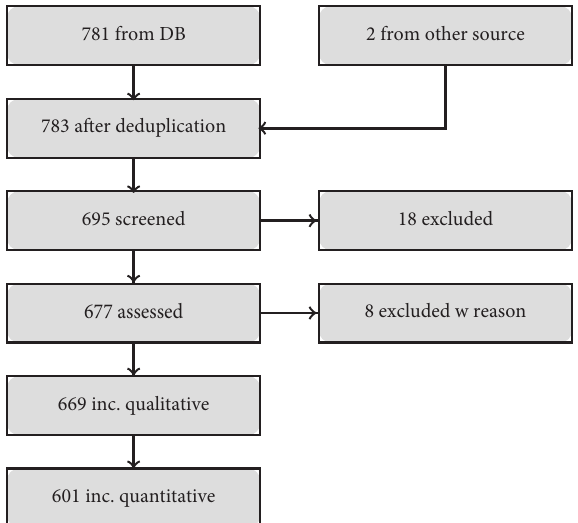
Figure 1: PRISMA processing